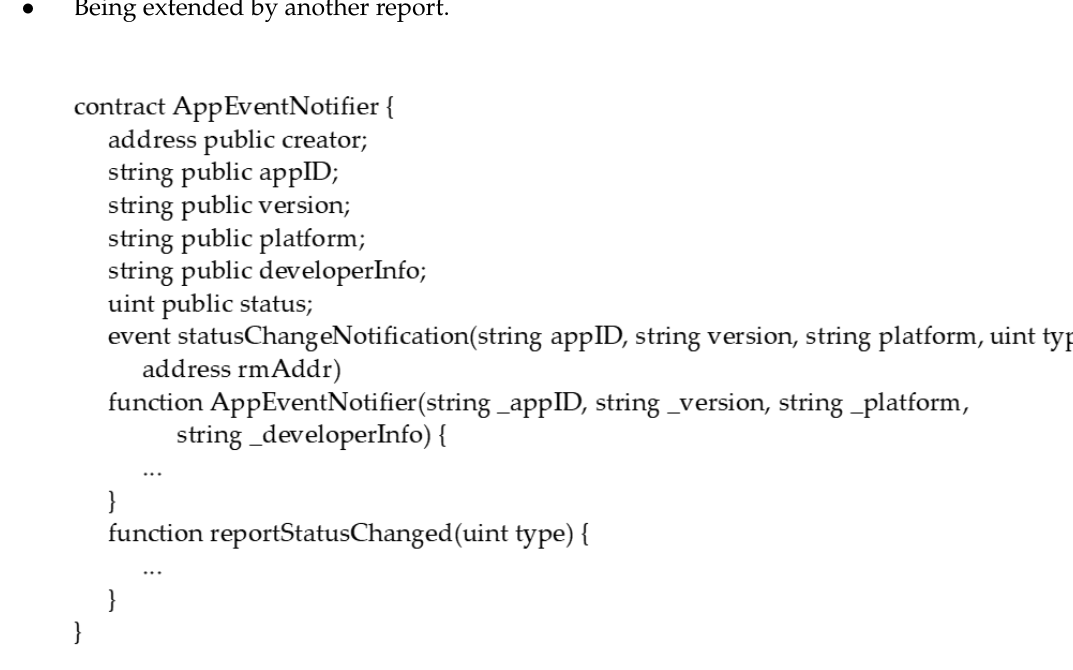
Figure 6. Abstract of the application event notifier smart contract.